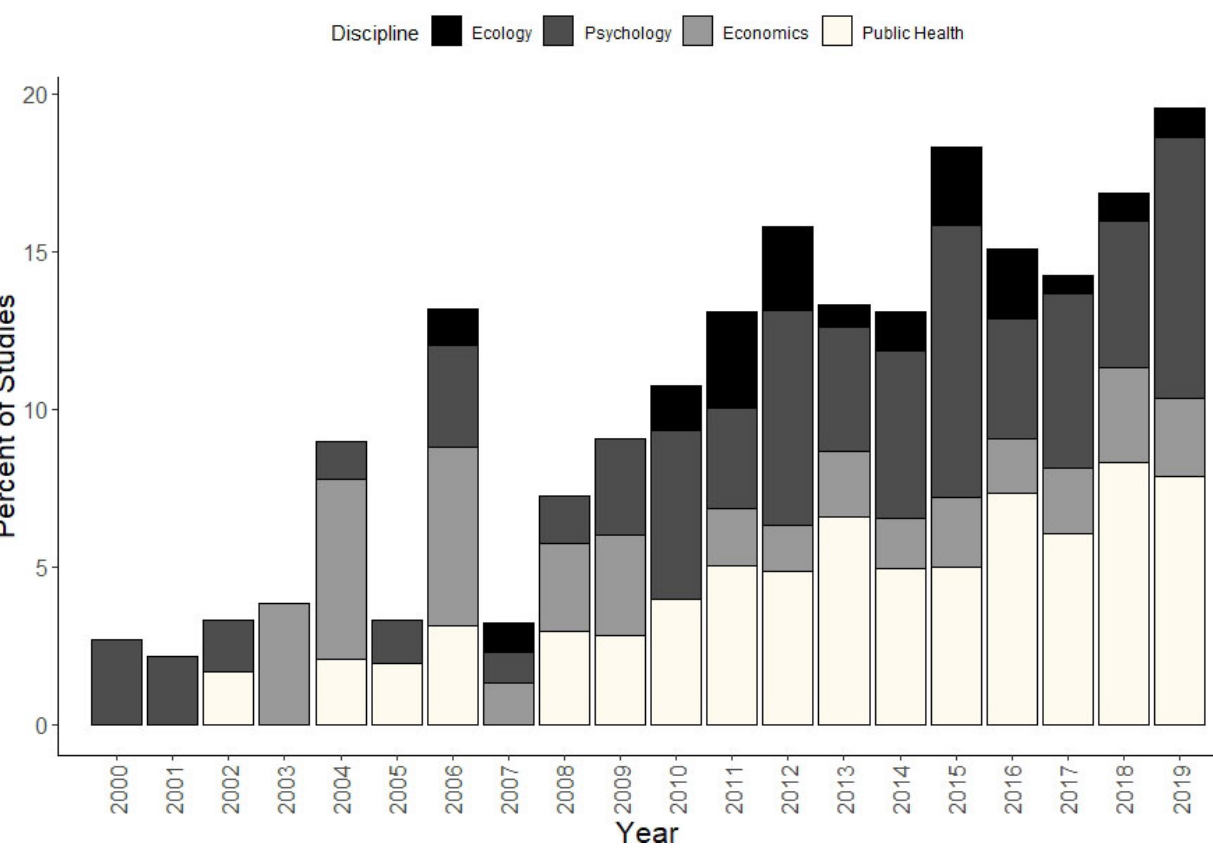
Fig. 6 . Percent of disaster-related peer-reviewed studies executing community engaged research (CER) methods in the fields of ecology, psychology, economics, and public health between 2000 and